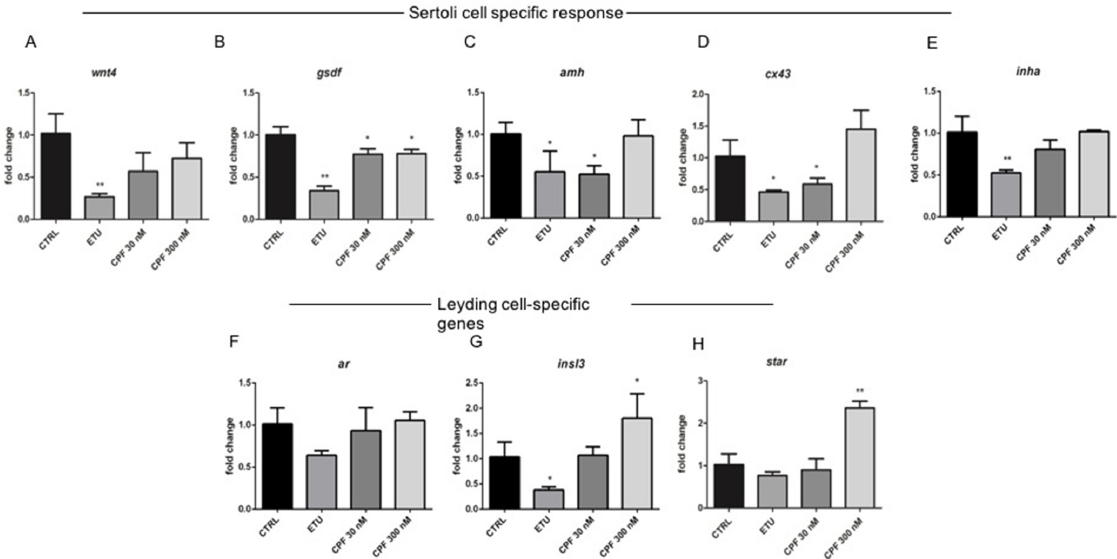
Figure 6. Developmental and life-long exposure to ETU and CPF affects gene expression of Sertoli and Leydig cells in Zebrafish. ( A – E ) RT-qPCR analyses of the levels of mRNAs markers of Sertoli cells proliferation and differentiation ( wnt4 , gsdf , amh , cx43 , inha ) and of Leydig cells ( ar , insl3 , star ) ( F – H ). RT-qPCR analyses were performed on dissected zebrafish adult testes (N° = 3 testis/group). Data analysis was conducted as described in M&M section. Data are reported as fold change values calculated as a ratio between average relative gene expression in treated and control, after normalization on β -actin mRNA. Mean and standard deviation are reported. Significant difference from the control group is indicated by * p < 0.05, ** p < 0.01. One-way ANOVA (post hoc test: Dunnett’s) was used.